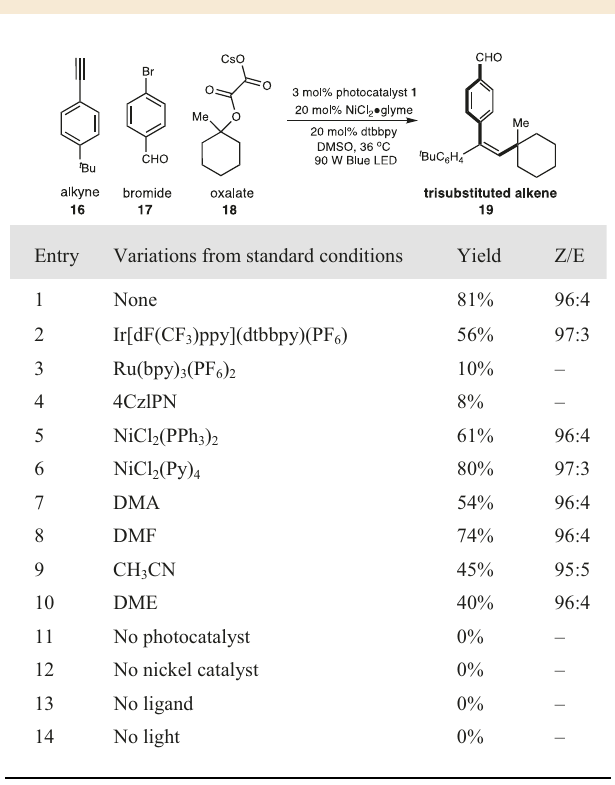
Table 1 Optimization of reaction conditions.